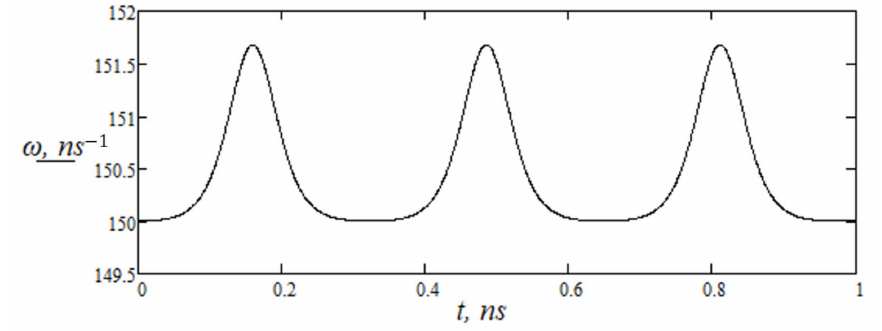
Figure 7. Module of angular velocity of nanotorus with “frozen”